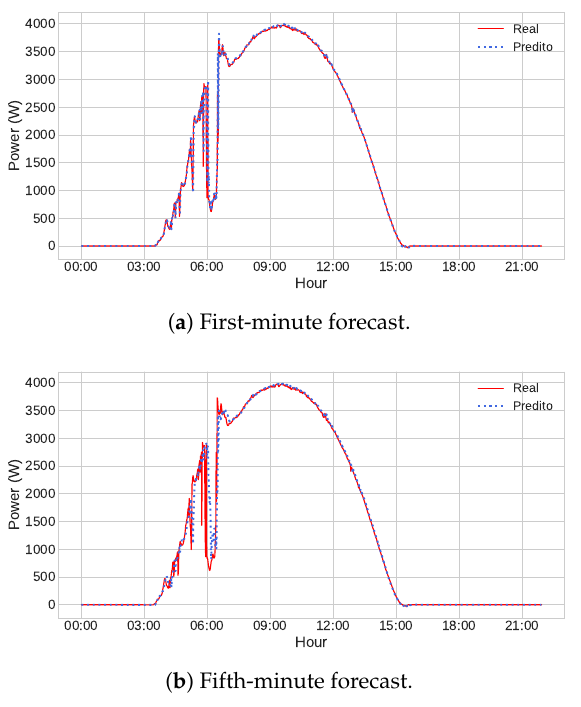
( b ) Fifth-minute forecast. Figure 9. Power forecast by the optimized LSTM model (blue dots) and the actual power values (red line) on the partially cloudy day of 01/22/2022, considering ( a ) the first-minute forecast and ( b ) the fifth-minute